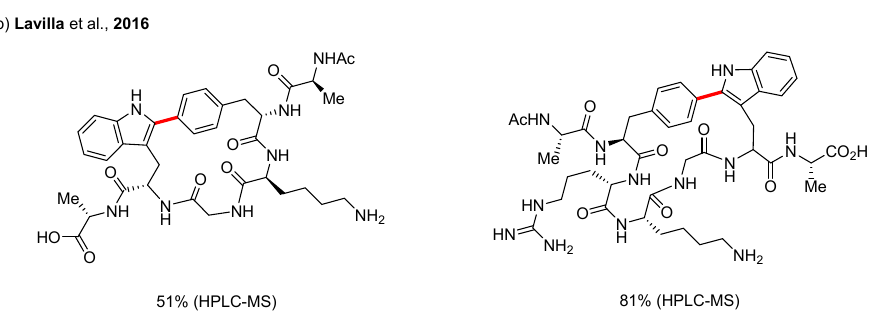
Figure 8. Synthesis of stapled peptides via palladium-catalyzed intramolecular C(sp 2 )–H bond arylation